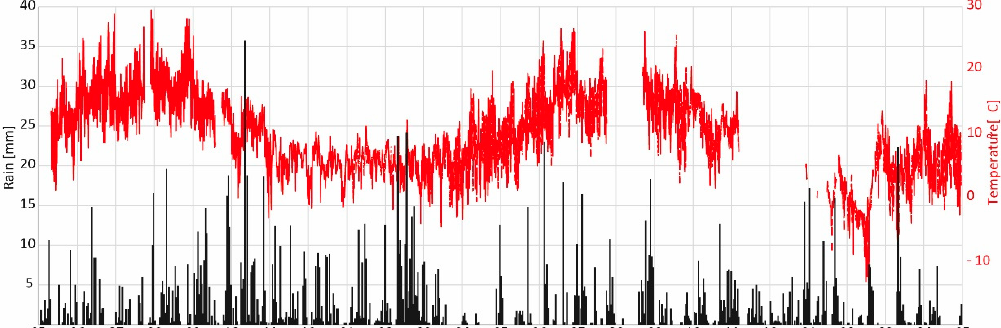
Figure 4. Temperature (red) and rain (black) during the project